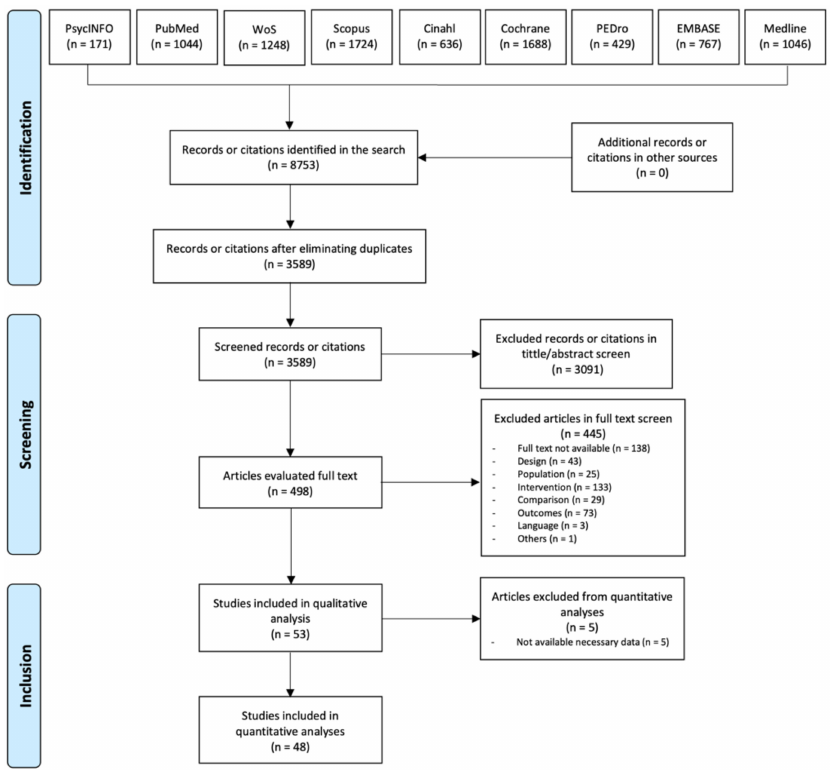
Figure 1. Preferred Reporting Items for Systematic Reviews and Meta-Analyses (PRISMA) flow